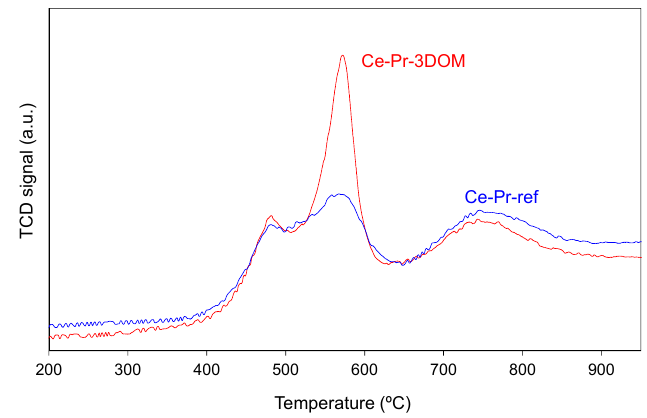
Figure 8. Characterization of the fresh catalysts by Temperature ‐ programmed reduction with H 2 .